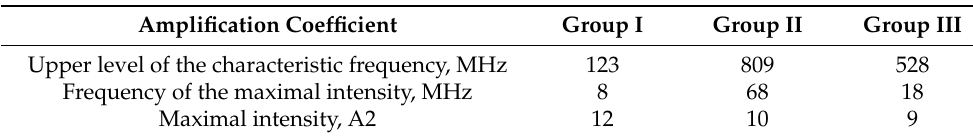
Table 7. Spectral characteristics of the signals induced with nearby impulse streamer corona on the elongated model elements (average